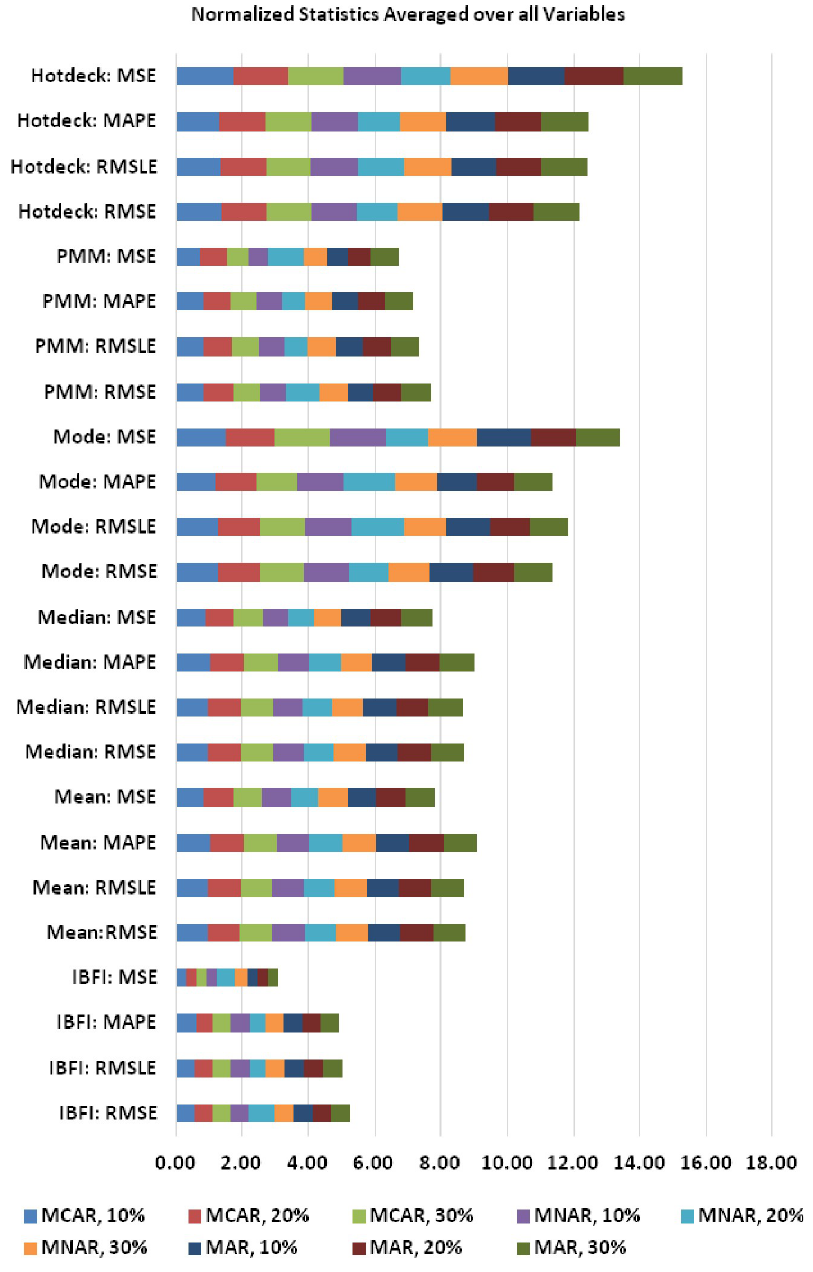
Fig 5. Statistics for IBFI compared with other methods (mean, median, mode, PMM, Hotdeck) normalized to the average statistic for all methods averaged across different variables, showing RMSE, RMSLE, MAPE, and MSE.